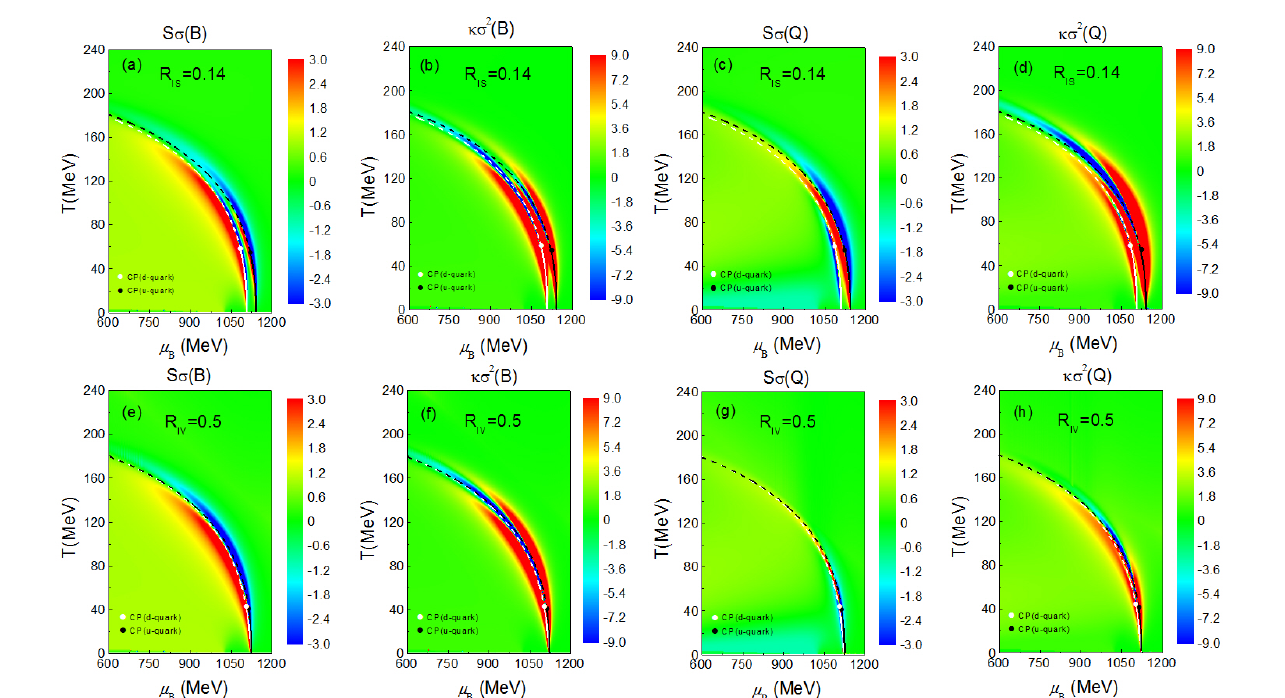
Figure 1. (color online) Skewness and kurtosis of net-baryon (B) ( a , b , e , f ) and net-charge (Q) ( c , d , g , h ) fluctuations in the µ B − T plane with finite scalar–isovector ( a – d ) and vector–isovector ( e – h ) coupling constants and the empirical relation µ I = − 0.293 − 0.0264 µ B with both µ B and µ I in MeV. The chiral phase transition boundaries and the corresponding critical points (CP) of u (black) and d (white) quarks are plotted in all panels for